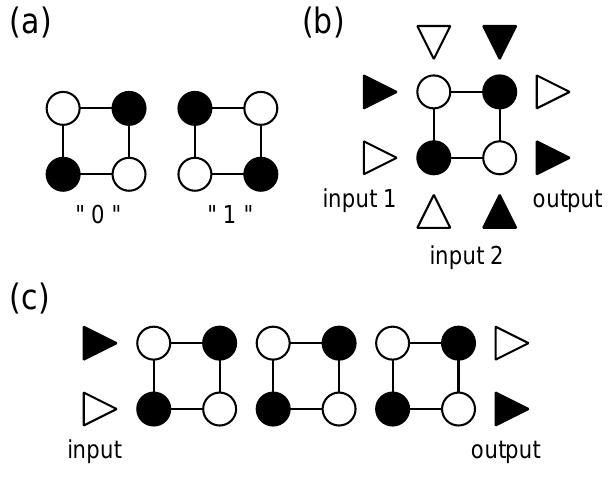
Figure 1. (a) Two degenerate states of QCA cell, ”0” and ”1”. Some applications of QCA cell: (b) QCA logic gate (AND gate) and (c) QCA signal transmission wire. Charge of open circles and triangles is more positive relative to that of filled circles and